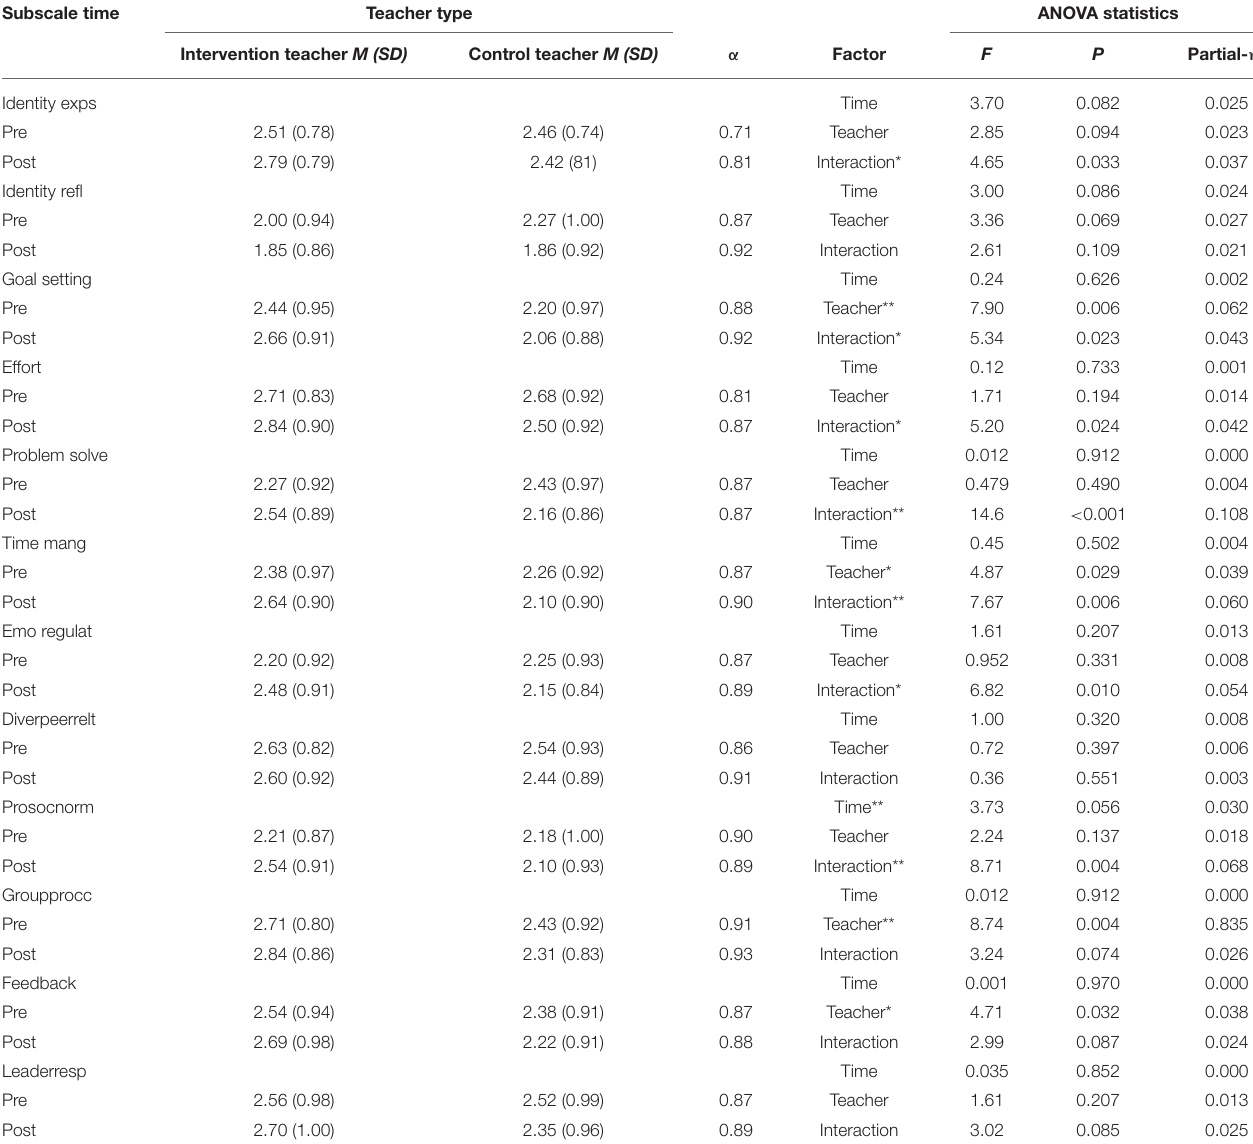
TABLE 3 | ANOVA table for the subscales of the YES 2.0 by teacher and time. Subscale